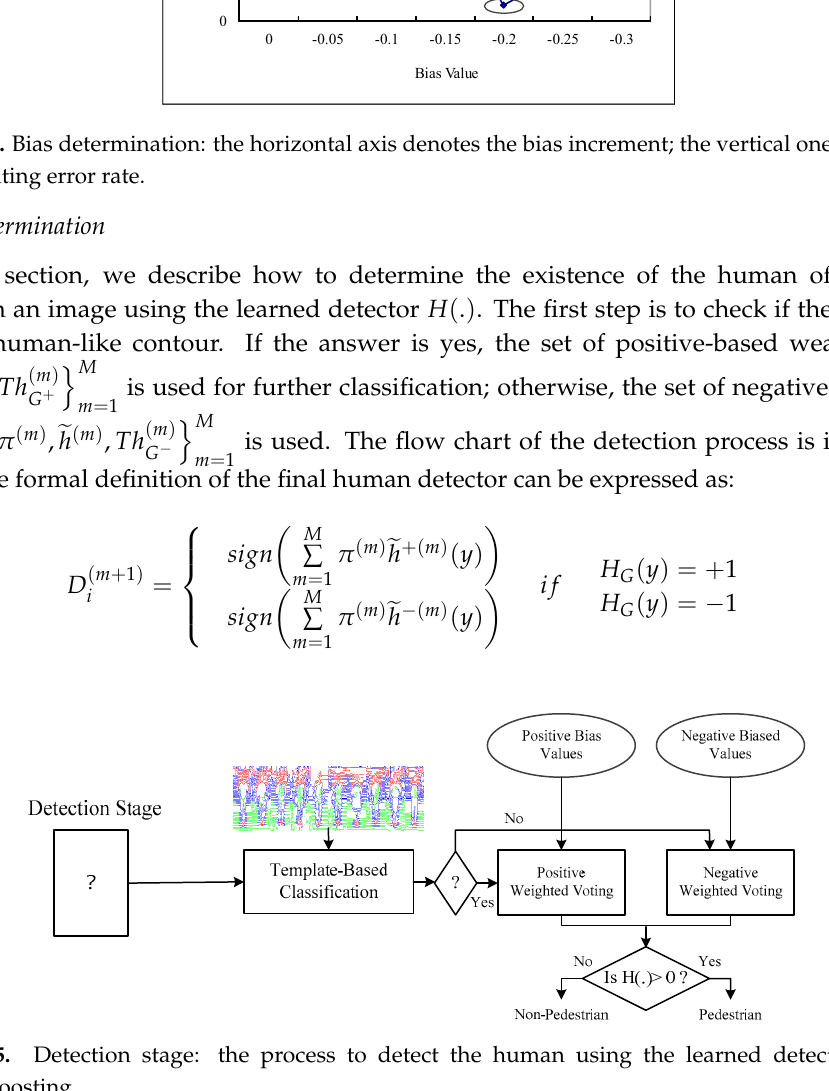
Figure 5. Detection stage: the process to detect the human using the learned detector from biased boosting.